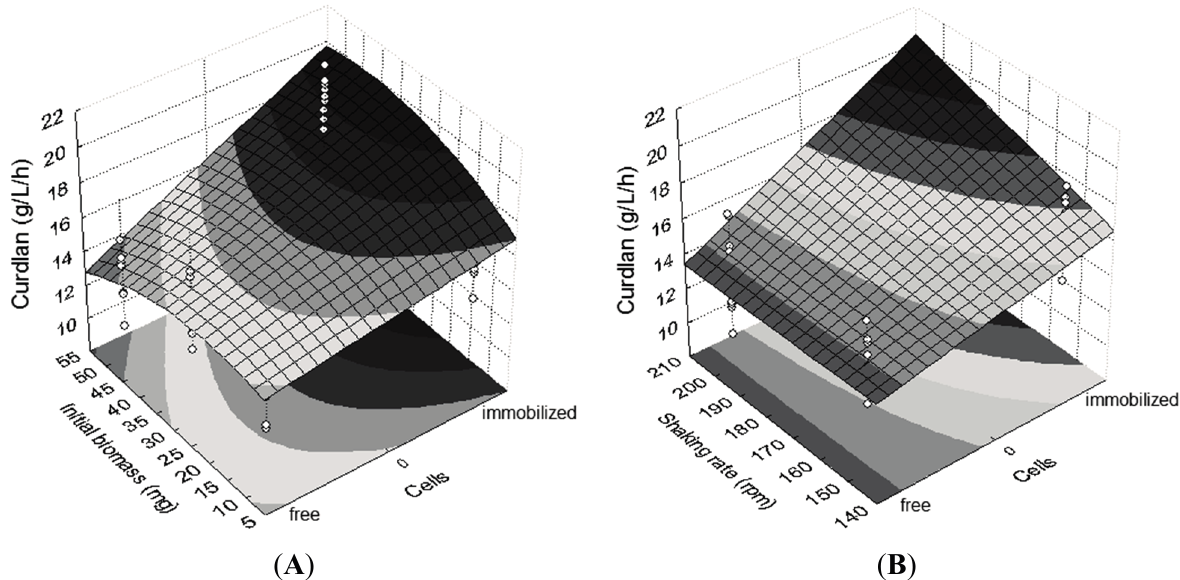
Figure 2. Contour plots emphasizing different effects on curdlan production. ( A ) Interaction between cells (immobilized and free) and initial biomass (10 mg, 30 mg and 50 mg); ( B ) interaction between cells (free and immobilized) and shaking rate (150 rpm and 200 rpm). Shaking rate in (A): 200 rpm. Initial biomass in (B): 50 mg. Incubation time: 72